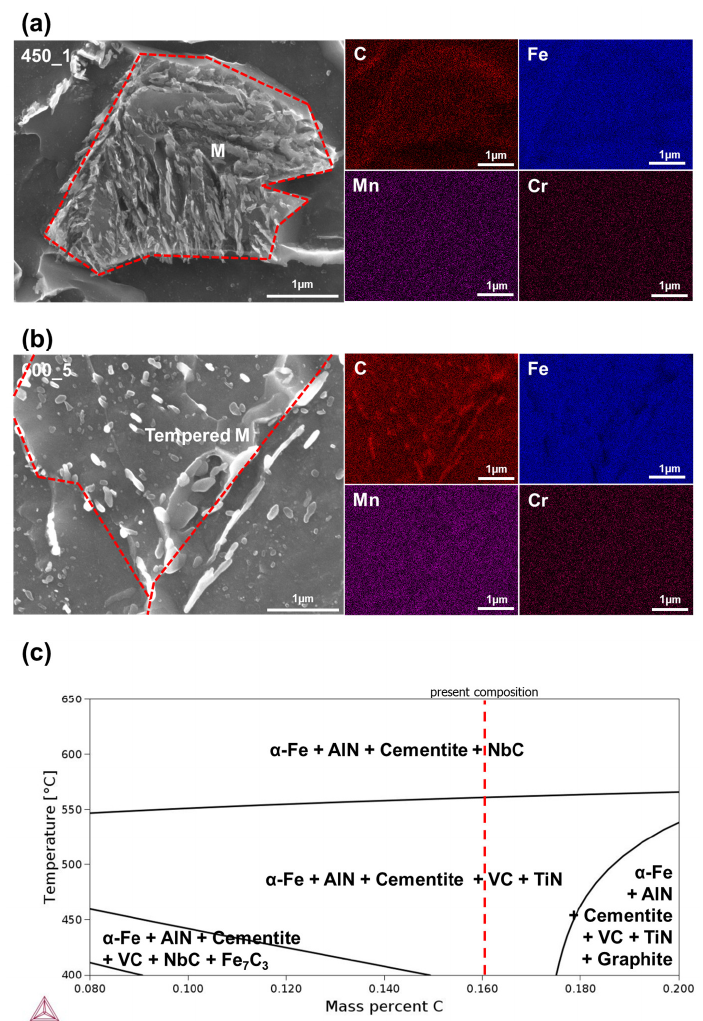
Figure 7. EDS analysis of carbides in decomposed martensite in ( a ) 450_1 and ( b ) 600_5 specimens. ( c ) Calculated equilibrium phase diagram of the present alloy.